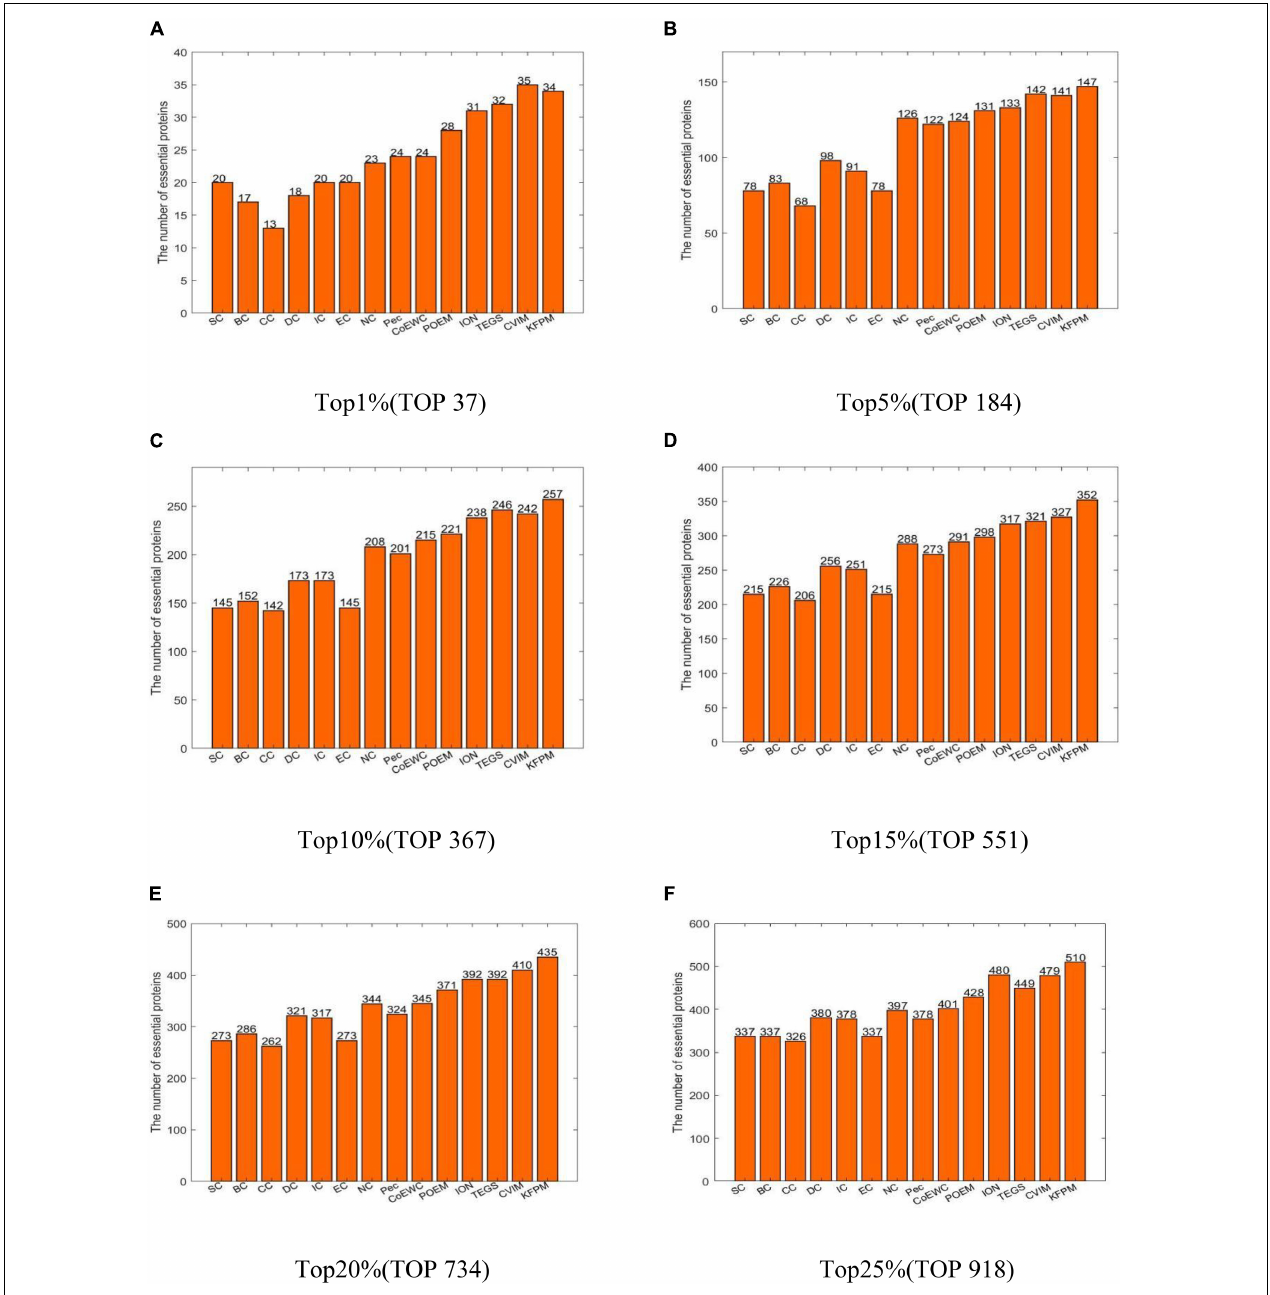
FIGURE 3 | Performance comparison between KFPM and 13 competitive methods based on the Krogan database (A) Top 1% ranked proteins. (B) Top 5% ranked proteins. (C) Top 10% ranked proteins. (D) Top 15% ranked proteins. (E) Top 20% ranked proteins. (F) Top 25% ranked proteins.